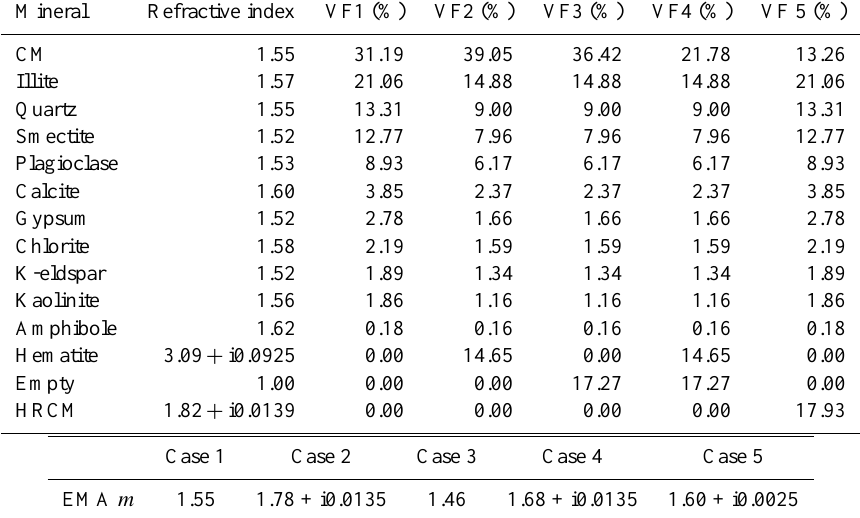
Table 1. The mineral contents for each of the inhomogeneous cases. CM refers to clay mixture, Empty refers to internal pores, and HRCM refers to hematite-rich clay mixture. Volume fraction (VF) columns 1–5 correspond to Cases 1–5. Percentages may not sum to 100% due to rounding in the displayed values. EMA m values in the bottom part of the table show the homogenized refractive indices of each